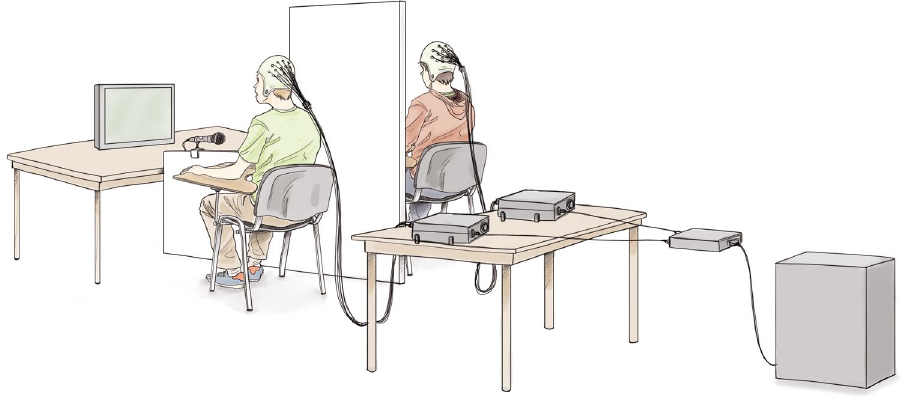
Figure 5. Experimental